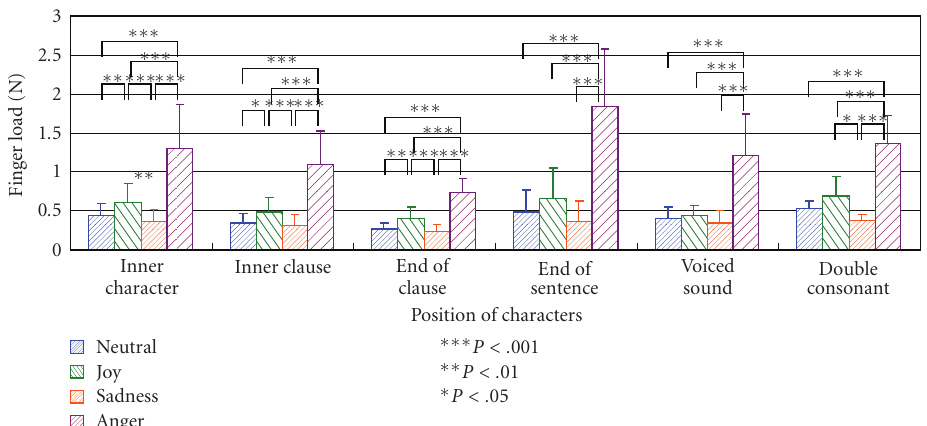
Figure 10: Mean of finger load as a function of emotions and position of characters for one-handed Finger Braille (error bars represent standard deviations).